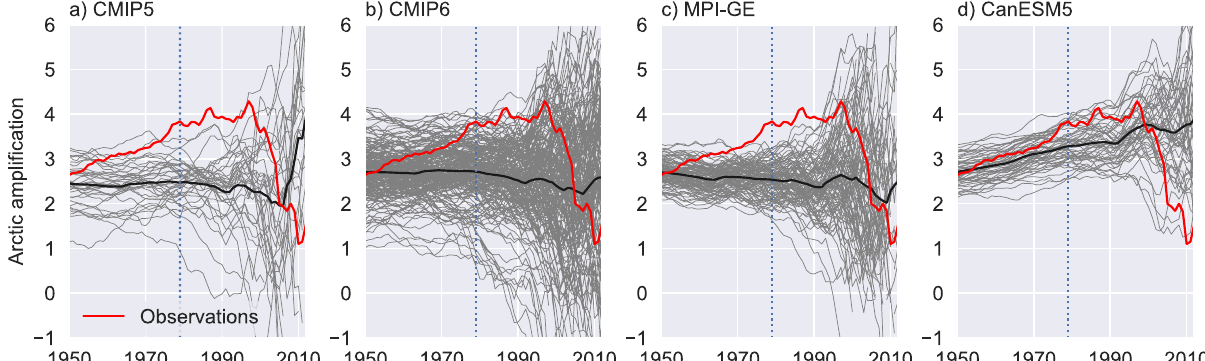
Fig. 4 Arctic ampli fi cation ratio as a function of the starting year of the trend in observations and climate models. Arctic ampli fi cation (AA) ratio as a function of the starting year of the trend derived from ( a ) CMIP5, ( b ) CMIP6, ( c ) MPI-GE and ( d ) CanESM5 realizations (thin grey lines). The end year of all linear trends is fi xed to 2021. Thus, for example, 1950 on the x-axis corresponds to AA calculated for 1950 – 2021. Thick black lines represents the ensemble mean AA, calculated as a mean of ratios, not ratio of means. AA ratios shorter than 10 years are not shown. The dashed vertical line represents the 43-year AA, as calculated for 1979 – 2021. The Arctic is de fi ned as the area north of 66.5 ∘